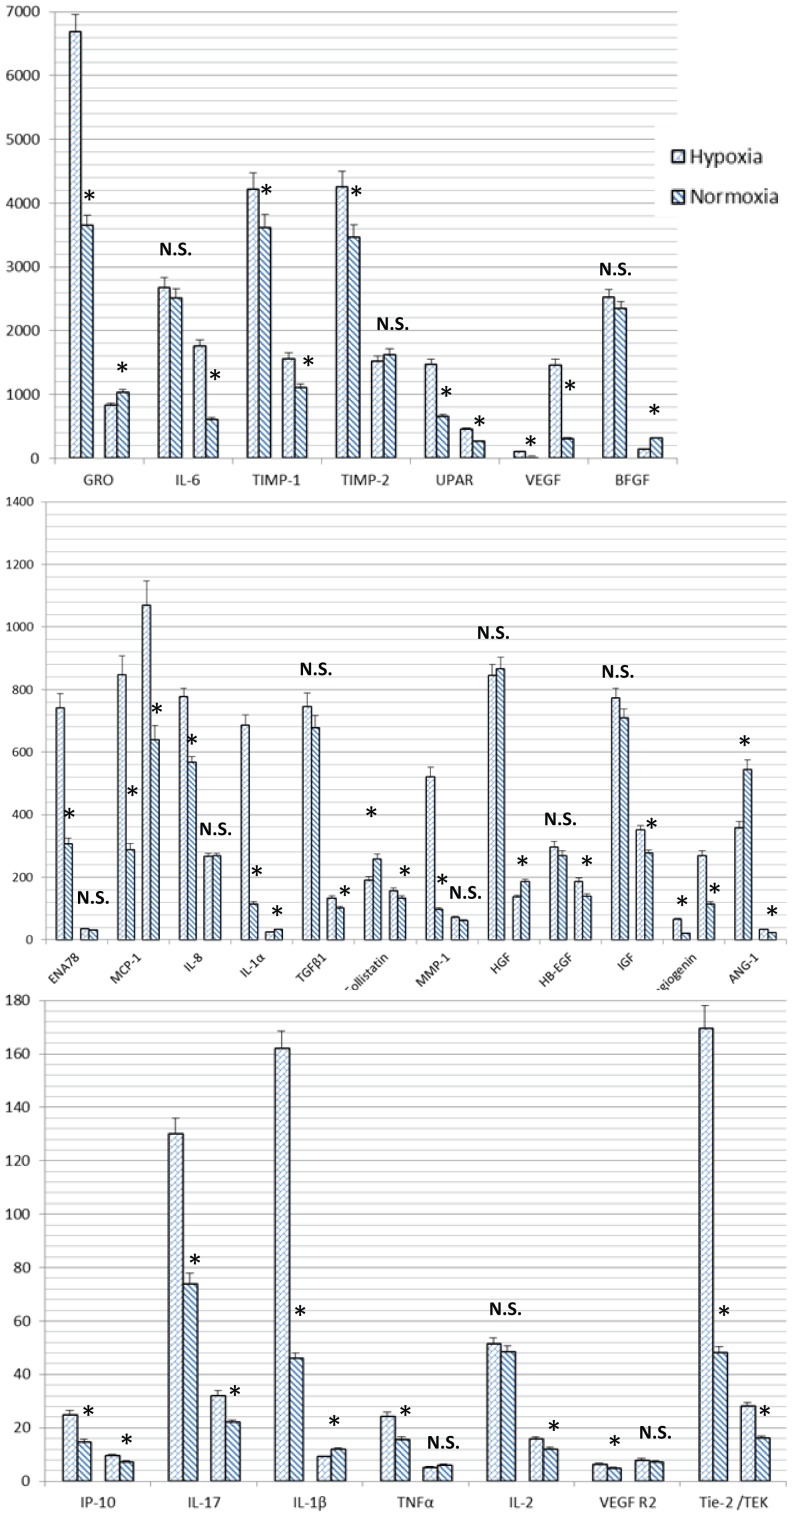
Comparison of cytokine concentrations (pg/ml) under hypoxic and normoxic conditions detected by antibody array in MSCs and MVs.A represents MSCs and B represents MVs. Results are expressed as mean ± SD. *, P<0.05; N.S., P>0.05.